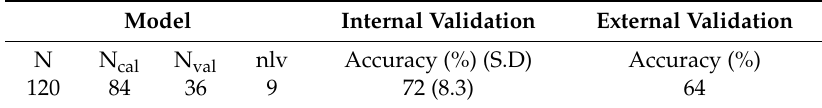
Table 3. PLS-DA model calibration and performance.